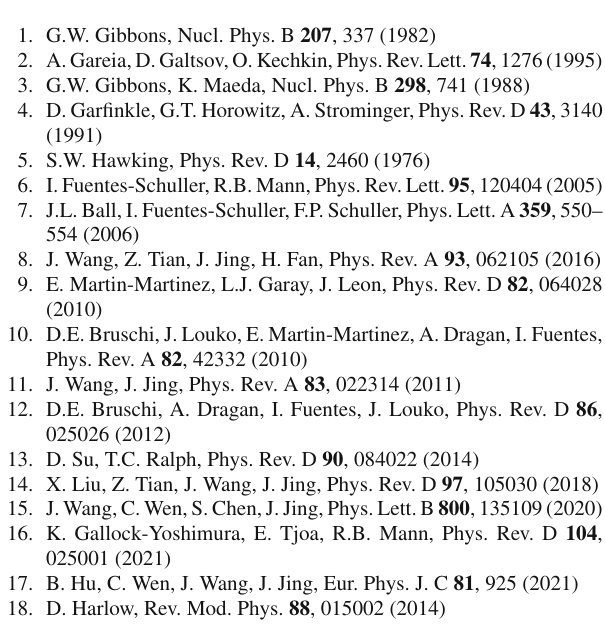
Fig. 4 a Plots of the quantum coherence between Bob and anti-Bob as a function of the ratio D / M . The initial squeezing parameter is fixed as s = 1. b The contour diagram of Gaussian quantum coherence between